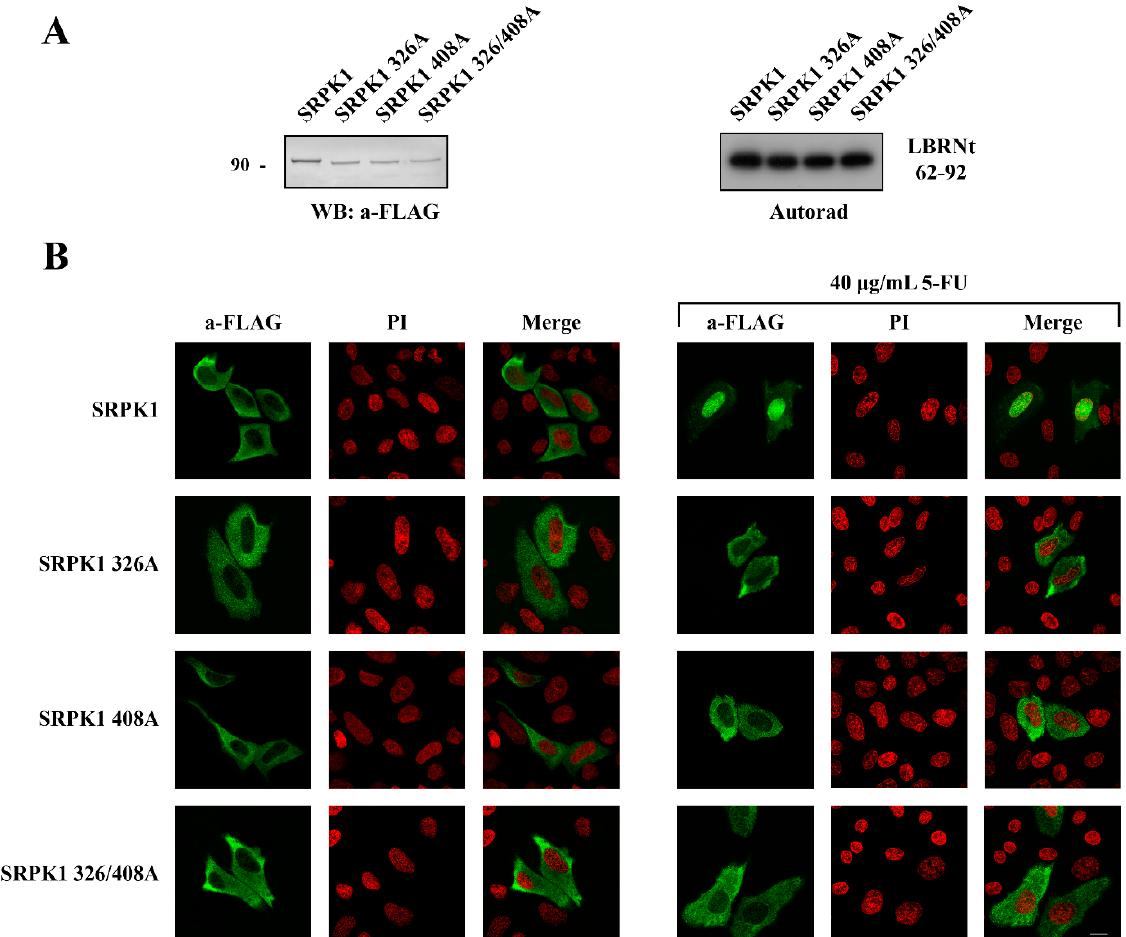
Figure 7. Phosphorylation of Thr326 and Ser408 was required for the nuclear translocation of SRPK1. ( A ) Western blot of the cell extracts prepared from HeLa cells transfected with FLAG-SRPK1, FLAG-SRPK1326A, FLAG-SRPK1408A, and FLAG-SRPK1326/408A ( left panel ). Phosphorylation of GST-LBRNt(62–92) by 0.5 μ g wild-type GST-SRPK1, GST-SRPK1326A, GST-SRPK1408A, and GST-SRPK1326/408A ( right panel ). ( B ) Fluorescent pattern of wild-type FLAG-SRPK1, FLAG-SRPK1326A, FLAG-SRPK1408A, and FLAG-SRPK1326/408A in the control and 5-FU-treated HeLa cells. In the transfected cells, the concentration of 5-FU was raised to 40 μ g/mL to achieve complete nuclear translocation of FLAG-SRPK1. SRPK1 was detected using the M5 anti-FLAG monoclonal antibody, while nuclei were stained with PI. Scale bar: 10 μ M.